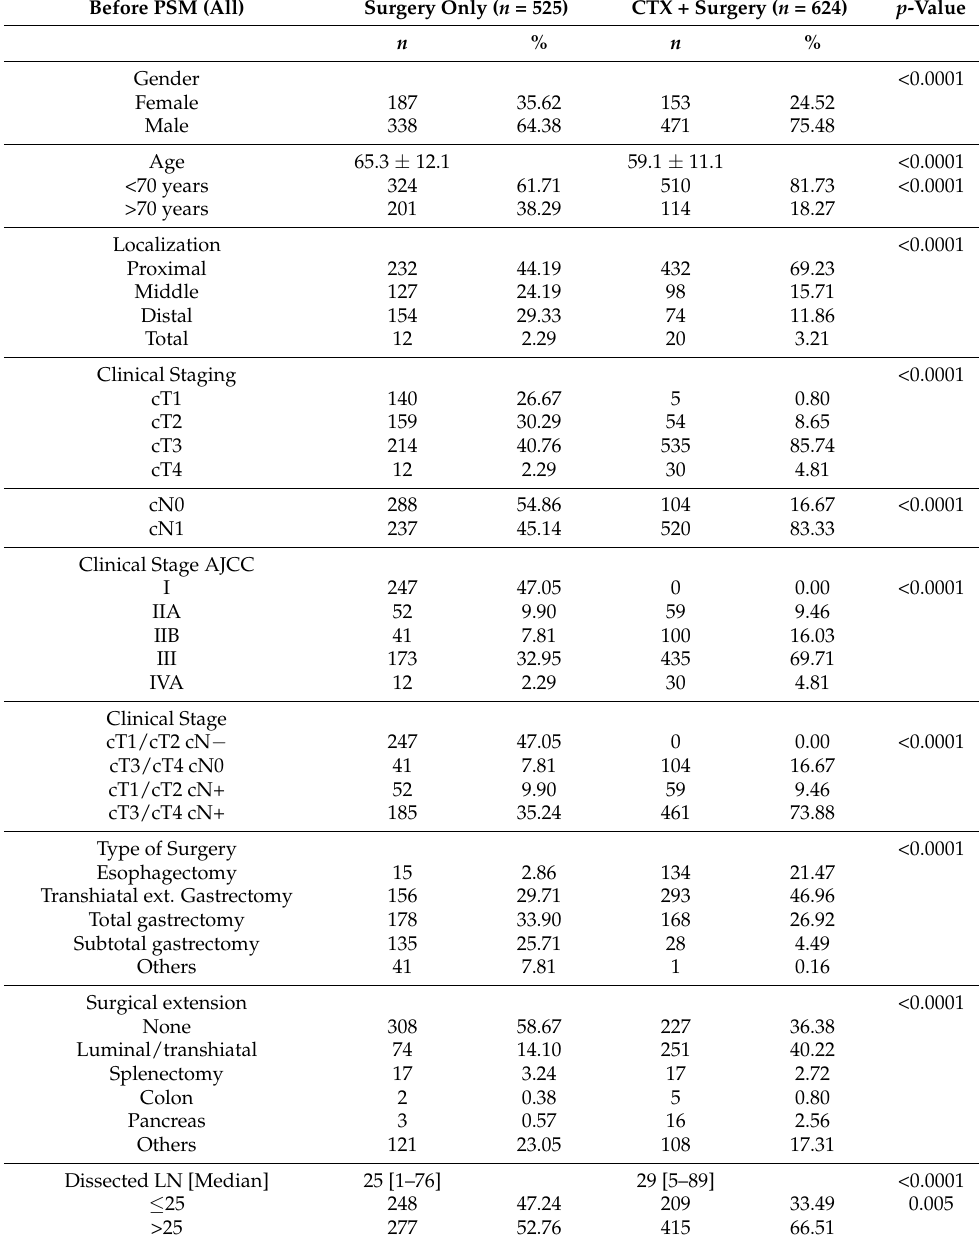
Table 1. Baselines before